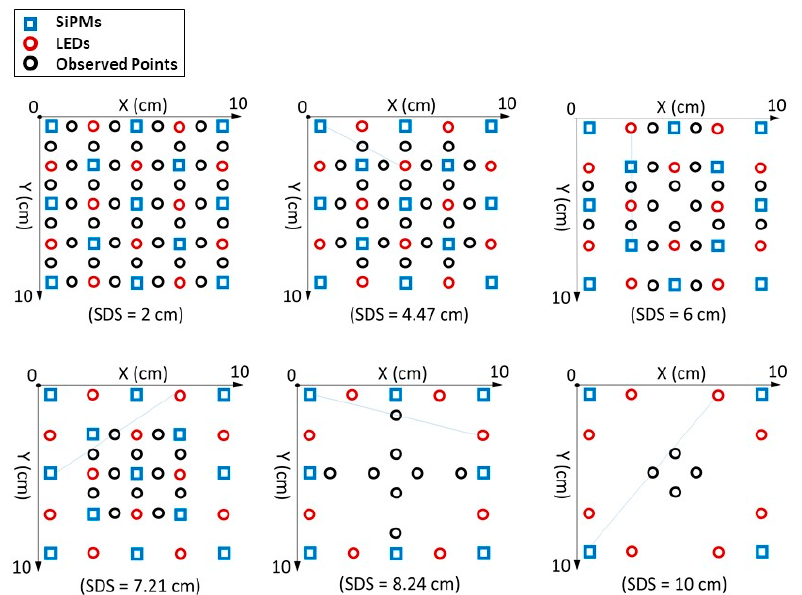
Figure 5. Maps of geometrical position of the tested points (black circles) for the case of the checkerboard pattern of SiPMs (blue squares) and sources (red circles) reported in Figure 1 .